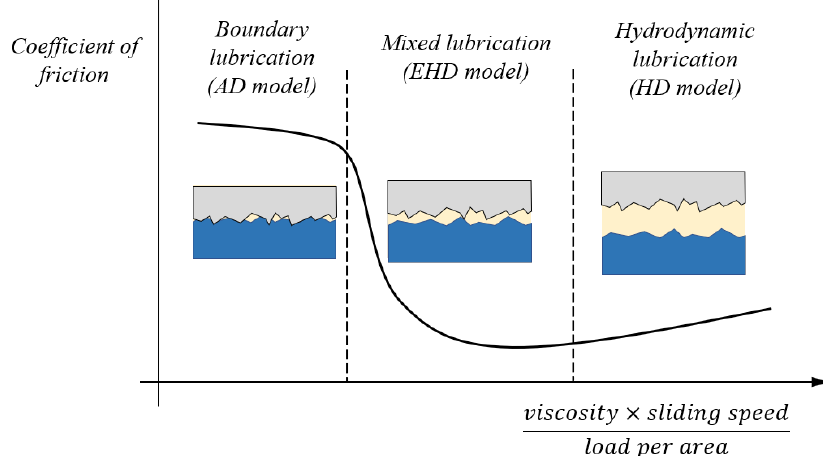
Fig. 1 Graphical illustration of different types of lubrication depending on friction